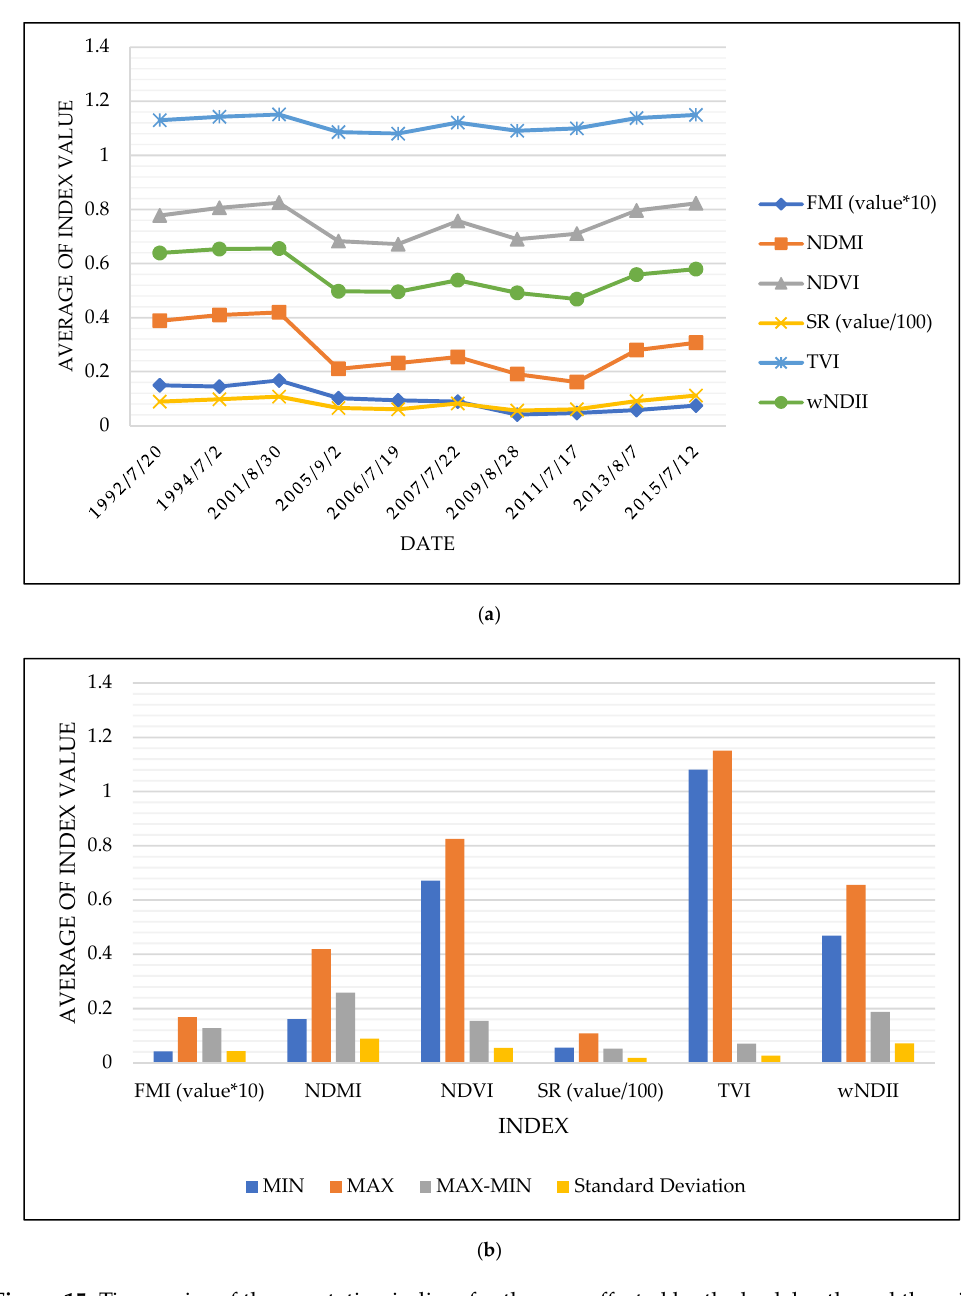
Figure 15. Time series of the vegetation indices for the area affected by the bark beetle and the wind calamity ( a ); and the statistical information ( b ) (the average from the Low Tatras National Park) (Source: Own work).